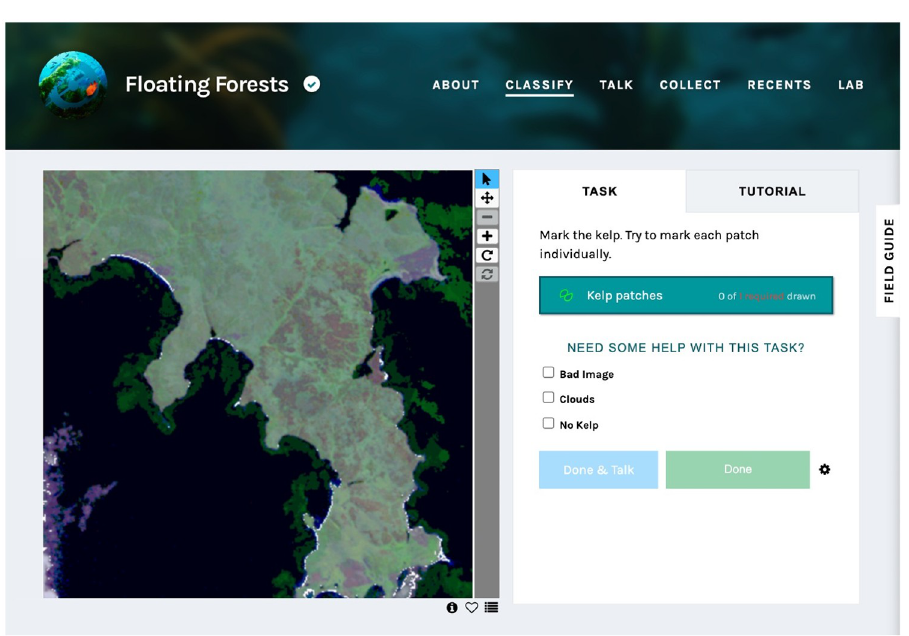
Fig 2. Zooniverse citizen science web portal. The Zooniverse interface in which citizen scientists indicate kelp canopy locations for the Floating Forests project. A representative tile viewing a portion of East Falkland is